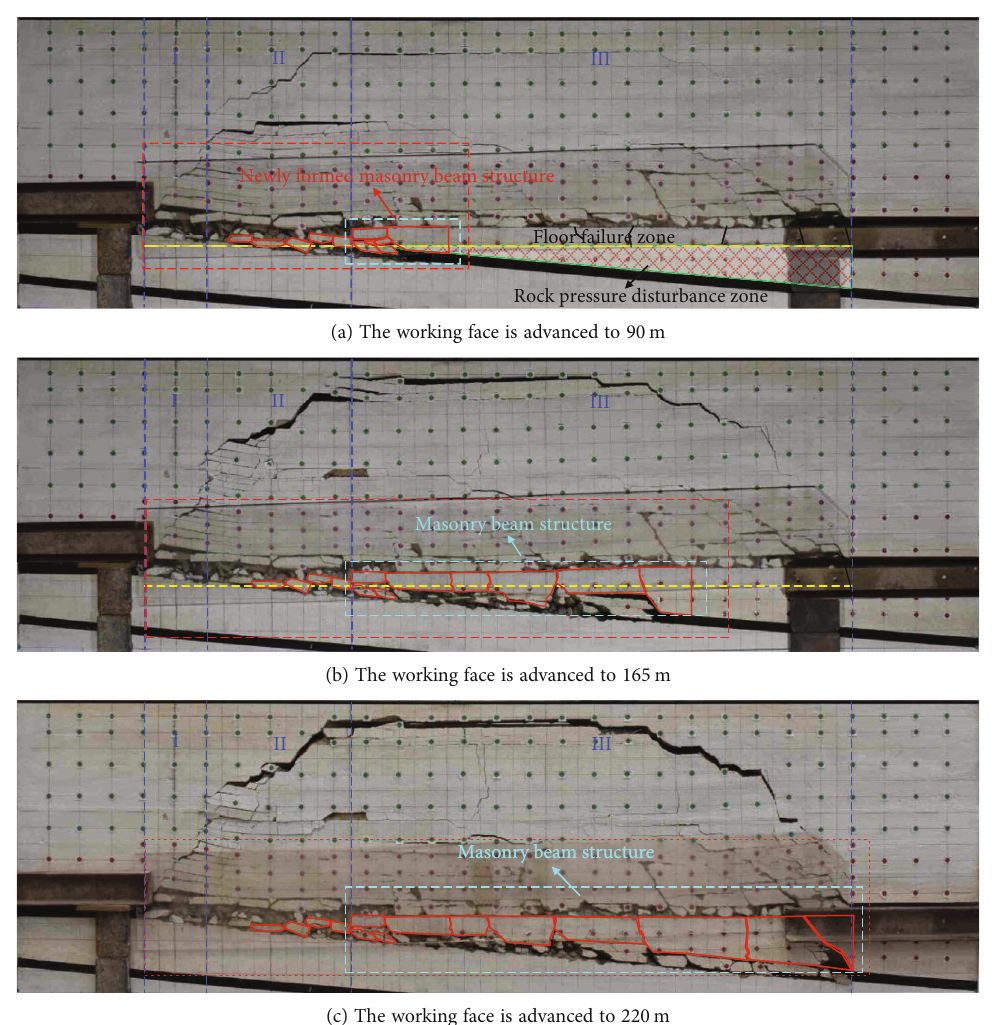
Figure 13: Schematic diagram of overburden fracture formation during advancement of the no. 7-2 coal seam to 90 m ~ 220